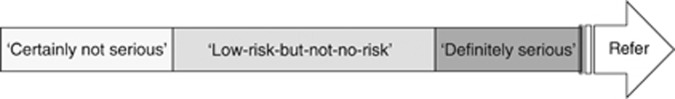
The symptom continuum in general practice. A symptom can present clinically in many ways.